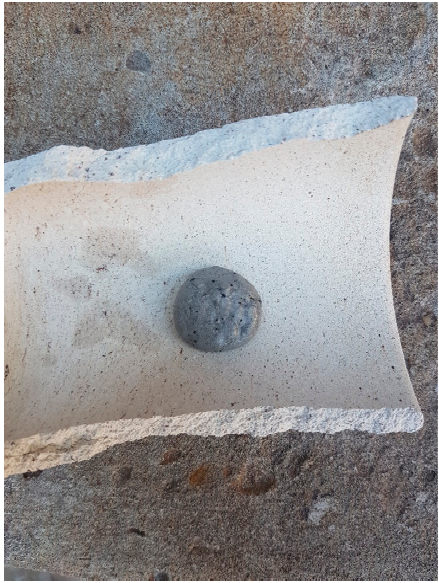
Figure 12. A platinum-rich button—the product of the illicit processing of flotation concentrates. The